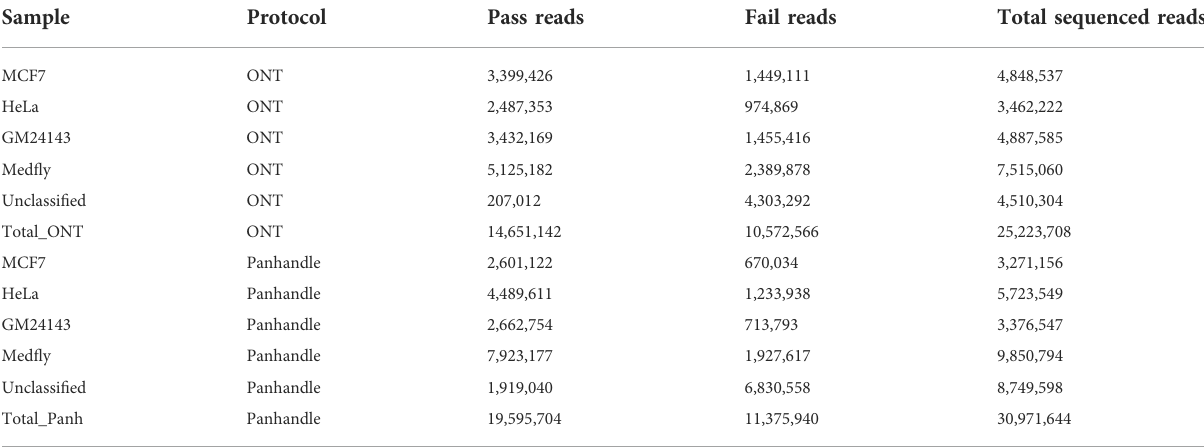
TABLE 3 Sequenced read statistics. Four samples, processed either with ONT or Panhandle protocol, were sequenced on the PromethION. The number of Pass reads (reads with Phred score of 9 and above), Fail reads (reads with Phred score of 8 and below), total reads is shown. Sample